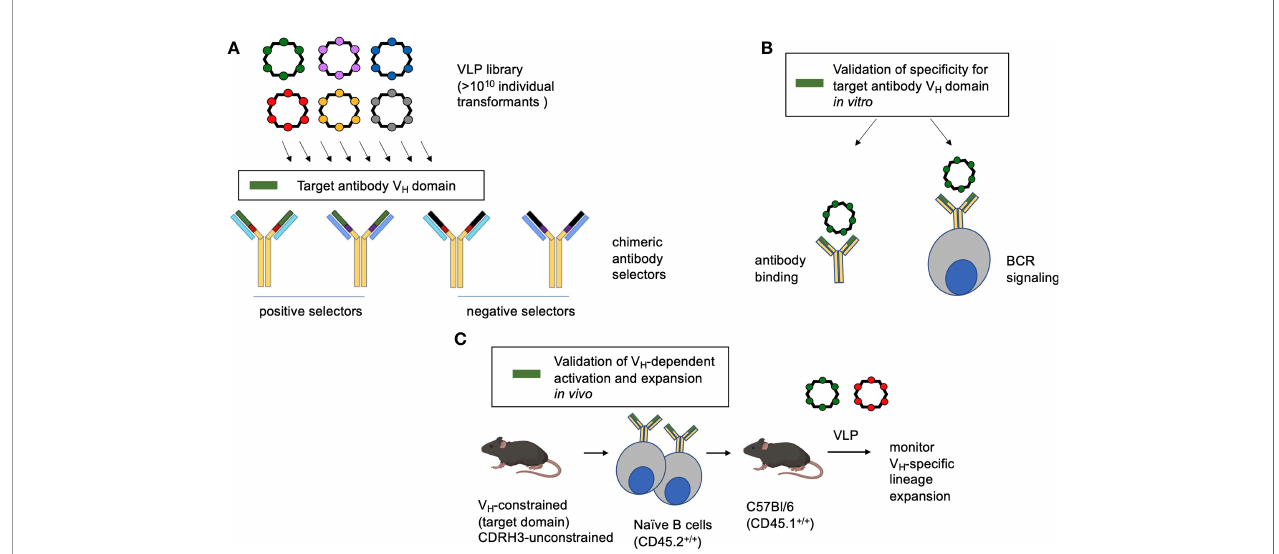
FIGURE 1 | Method overview. (A) A highly immunogenic RNA bacteriophage VLP platform has been engineered to display diverse guest peptide sequences. Each VLP encapsidates its own mRNA, meaning that the VLPs can be deployed for af fi nity selection. The library is then interrogated for speci fi city to antibodies with chimeric antigen binding sites, serving to identify VLP bearing af fi nity to a speci fi c antibody feature (in this study the human IGHV1-2*02 domain). (B) The identi fi ed VLP is then veri fi ed by antibody binding and its capacity to trigger the BCR con fi guration of interest when displayed by a reporter B cell line. (C) To evaluate the corresponding B cell lineage expansion in vivo , transgenic human-like CD45.2 +/+ BCRs constrained to the motif are adoptively transferred to recipient CD45.1 +/+ C57Bl/6 mice. In this case the adoptively transferred B cells are constrained in IGHV1-2*02 usage, but unconstrained all other BCR features and bear human-like diversity in CDRH3 (31,